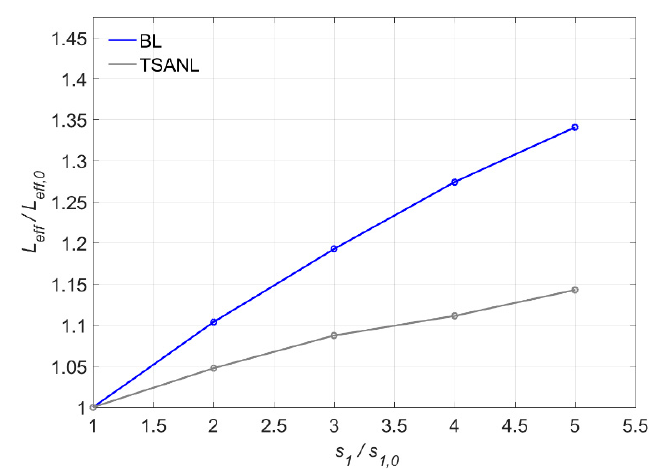
Figure 18. Variation of Leff versus s 1 .